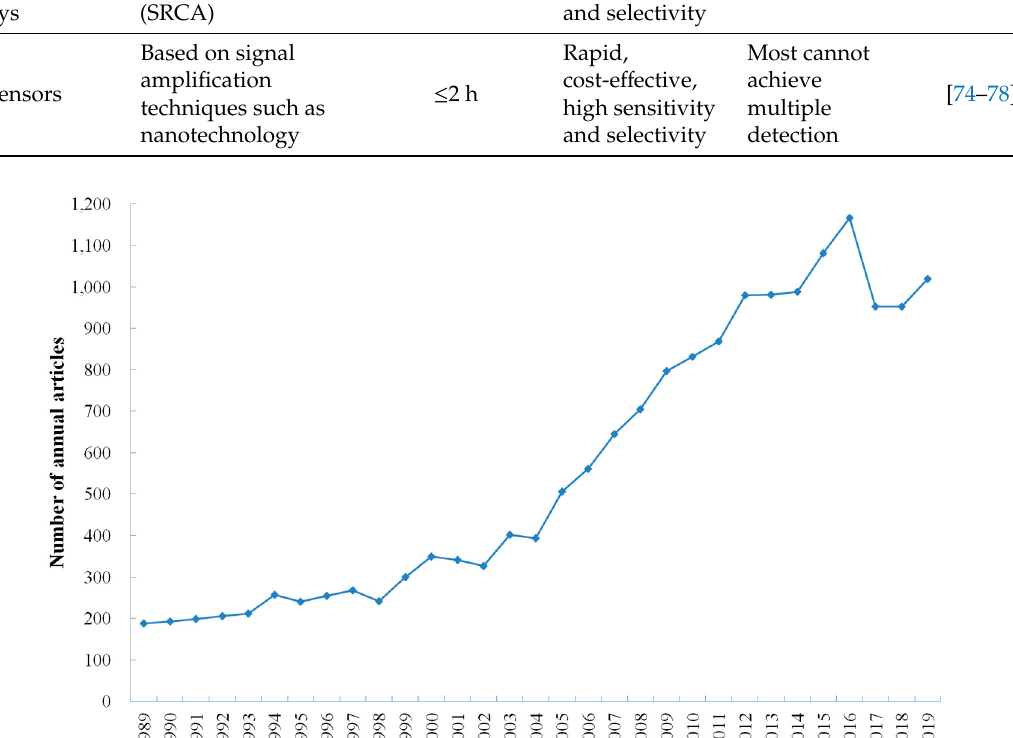
Figure 1. Components and classification of biosensor.